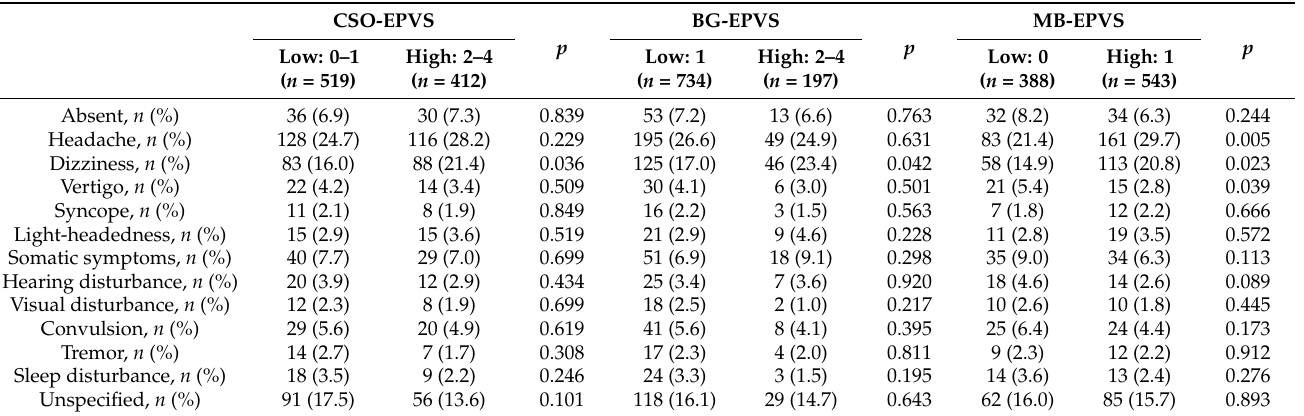
Table 3. The results of the chi-square analysis of the differences in the clinical symptoms and MRI findings between the groups according to the degree of EPVS.